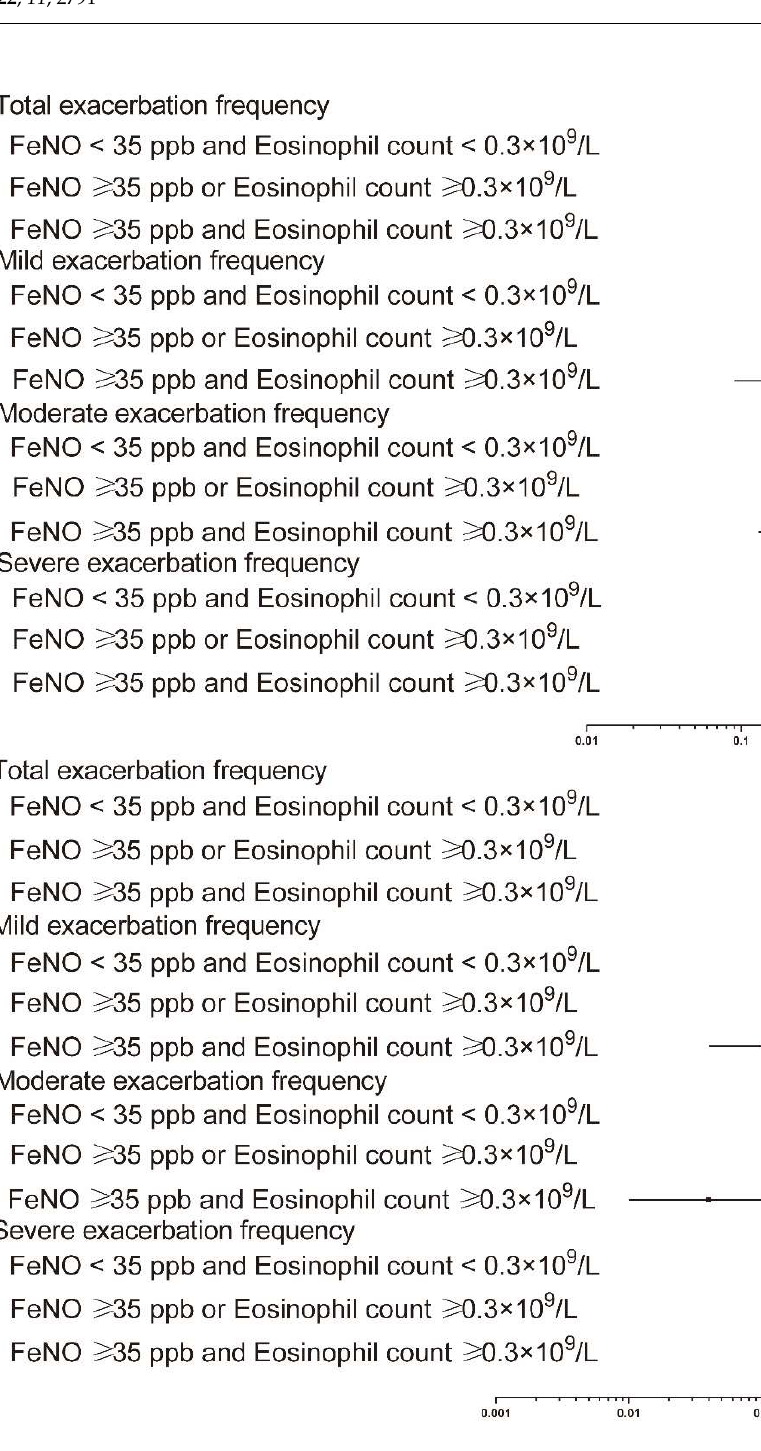
Figure 5. Combined association of increased FeNO level and blood eosinophil count with frequency of various degrees of acute exacerbation of COPD: ( A ) Smoking status adjusted; ( B ) multivariable adjusted. Poisson regression models were used. Multivariable adjustment included age, gender, BMI, smoking status, FEV 1 post-BD% pred, SGRQ, and 6-minute walking distance. FeNO, exhaled nitric oxide fraction; BMI, body mass index; FEV 1 , forced expiratory volume in 1 s; BD, bronchodilator; SGRQ, St. George’s Respiratory Questionnaire.